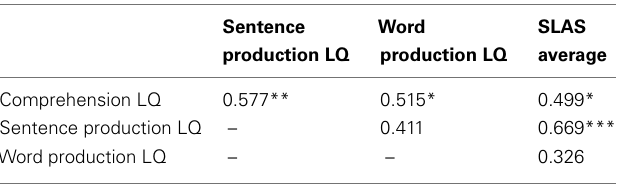
Table 2 | Correlation coefficients relating the language quotients and parental questionnaires at 3years.